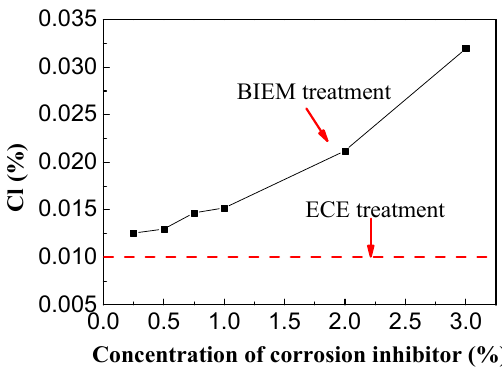
Figure 12. Relationship between corrosion inhibitor content and chloride ion concentration.